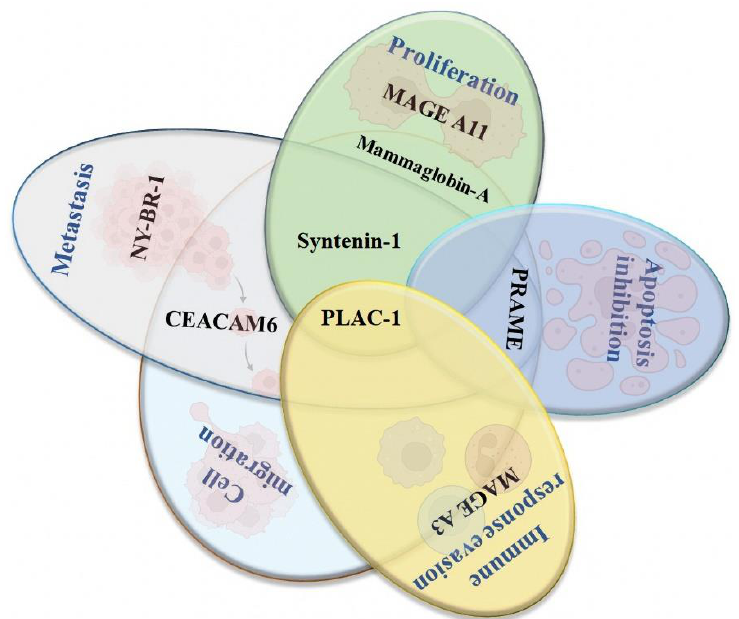
Figure 3. Venn diagram of novel potential targets for developing peptide-based vaccines. The selected antigens are involved in the different biological processes: proliferation, apoptosis inhibition, immune response evasion, cell migration, and metastasis. Image created in Biorender (https://biorender.com/ accessed on 2 July 2022).